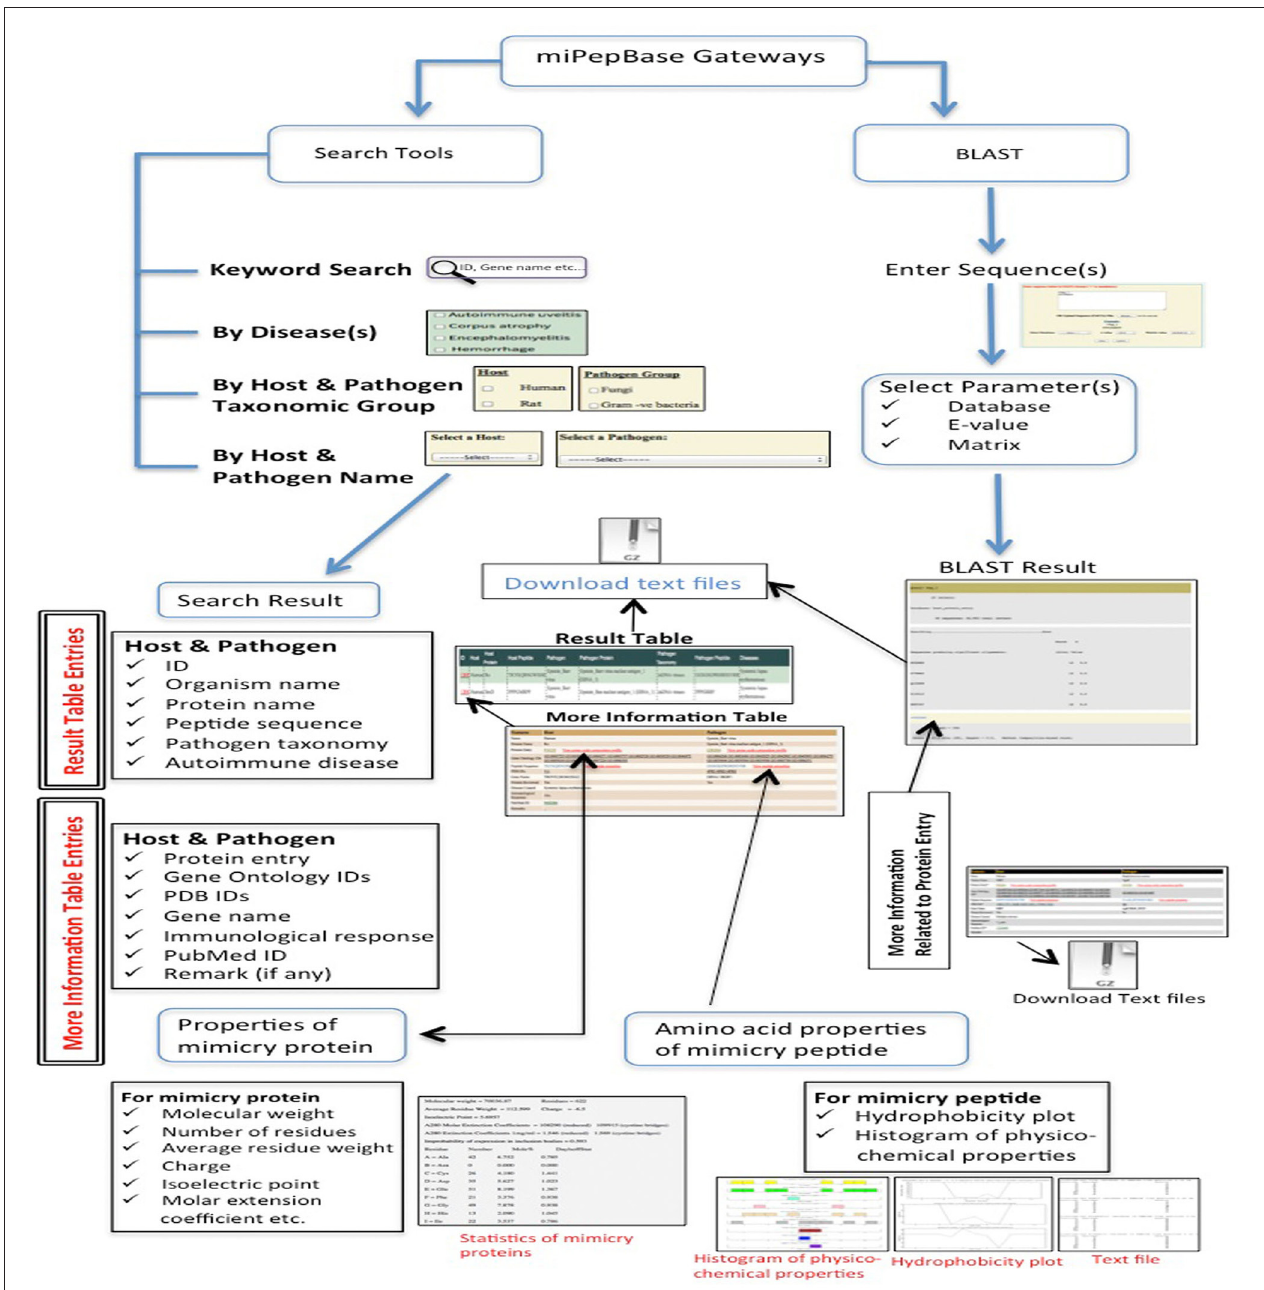
FIGURE 1 | Architecture of